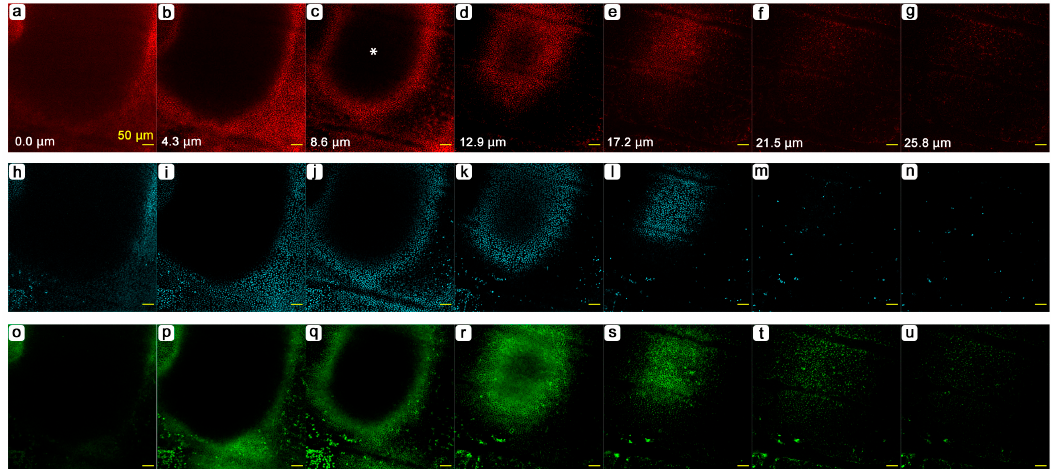
Figure 12. Serial optical sections of the dent at the prospective discal spot (the discal dent). This is a